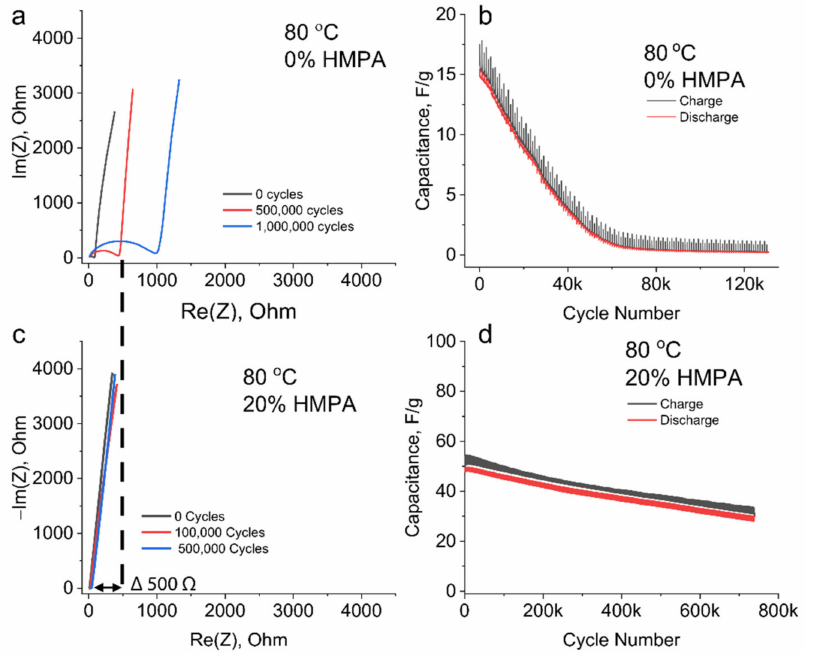
Figure 3. Electrochemical data of cells without HMPA at 80 ◦ C; ( a ) representative impedance data; ( b ) galvanic cycling data at 5 mA. There is clear evidence of cell degradation without the addition of HMPA. ( c ) Representative impedance data with 20% by wt. HMPA at 80 ◦ C; ( d ) galvanic cycling data (The spikes in the data are an artifact of how the data is taken. They occur after every EIS measurement). Note also that the initial capacitance of cells without HMPA at 80 ◦ C vary due to unaccounted for degradation while equilibrating at 80 ◦